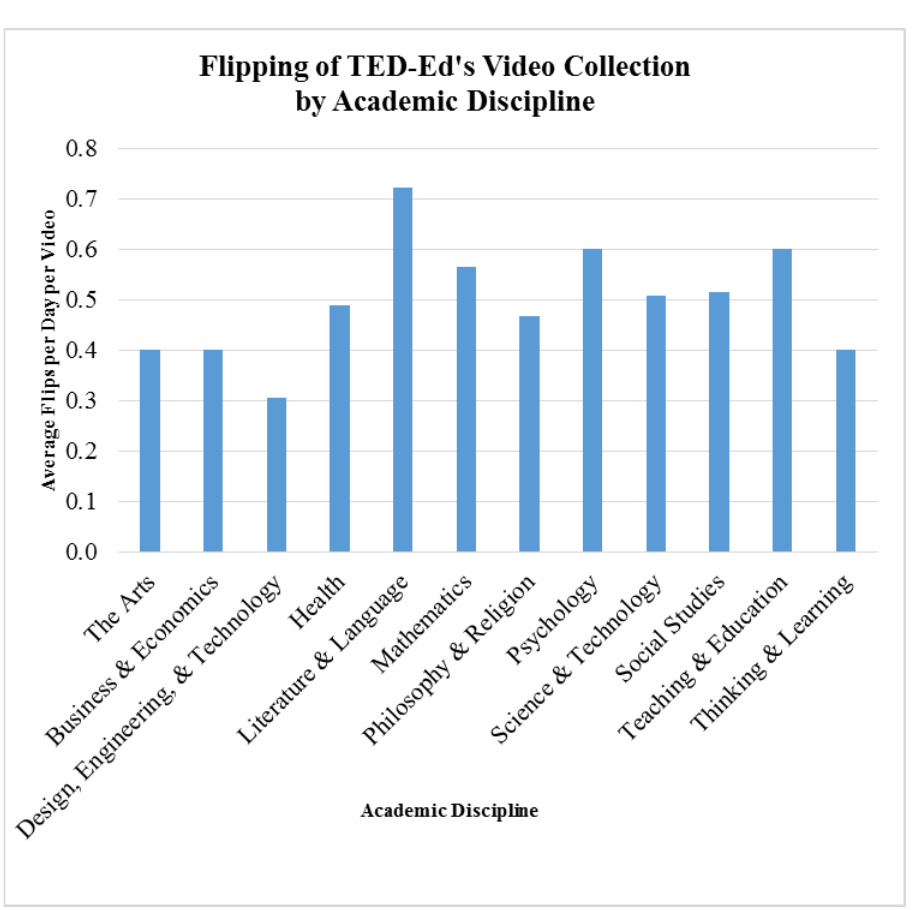
Figure 9 . Flipping by academic